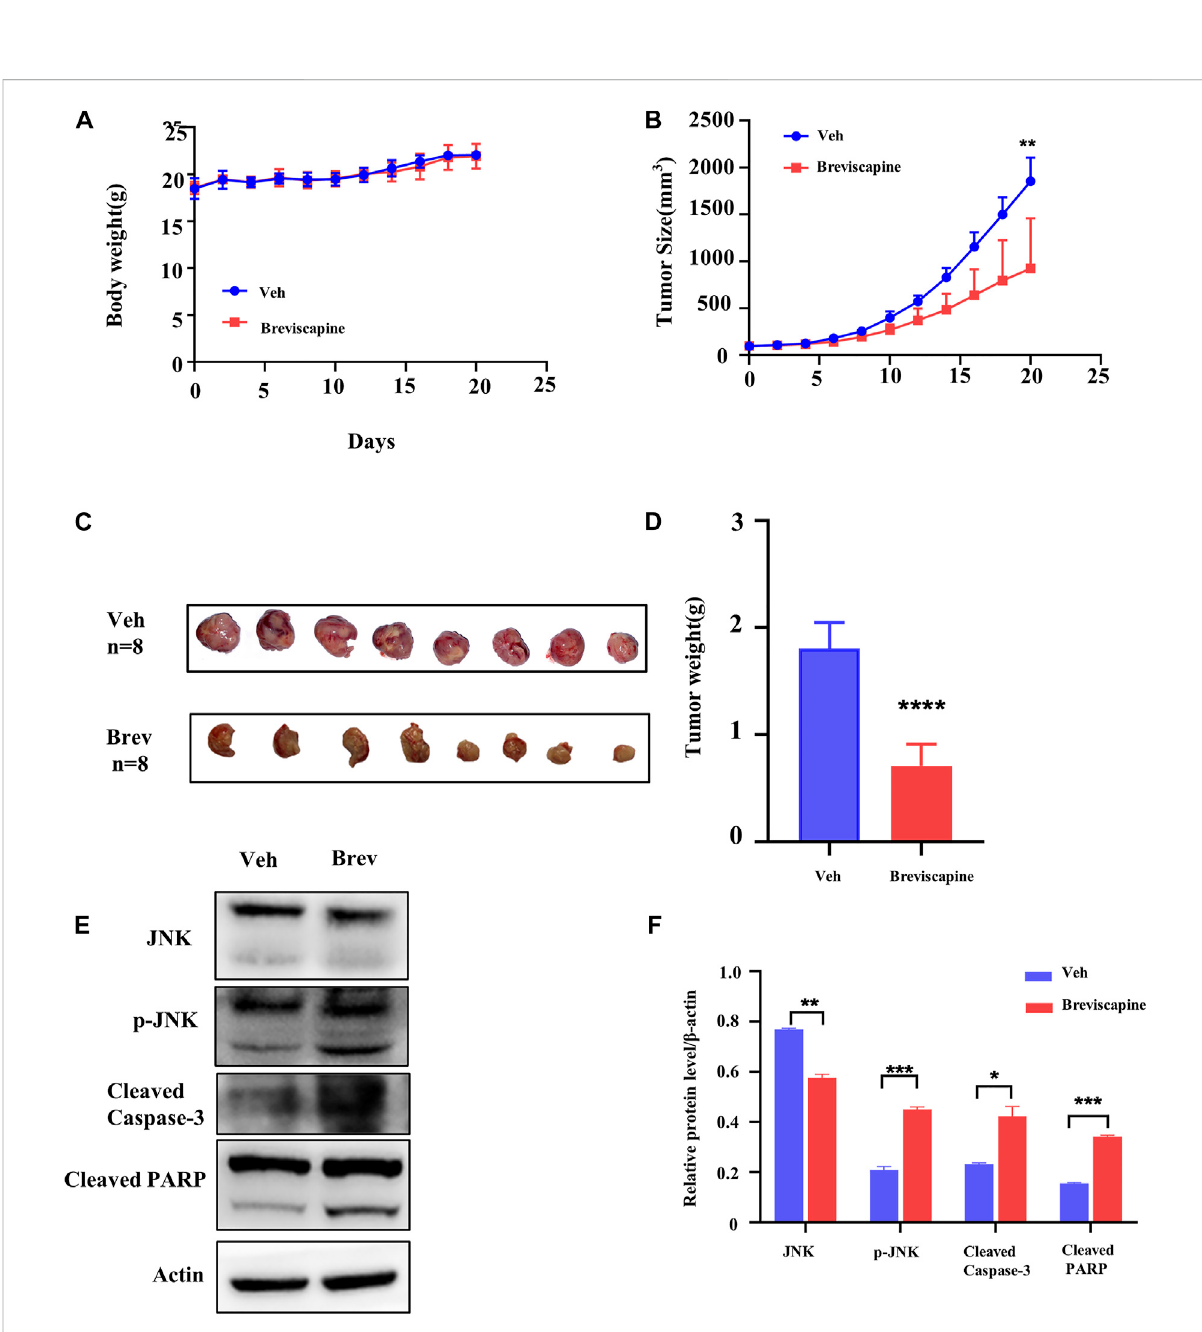
FIGURE 6 Scutellarinsuppressesxenograftgrowth invivo model. (A) Theaveragebodyweightinbreviscapine(60 mg/kg/d,po)andvehicle(normalsaline, po) groups. (B) Xenograft size from nude mice in breviscapine and vehicle groups. (C) Xenograft excised from nude mice in each group. (D) The averageweightofeachxenograft. (E) ThelevelsofJNK,p-JNK,cleavedCaspase-3andcleavedPARPinthetumorswithbreviscapinetreatmentwere evaluated by Western blotting. (F) The statistical analysis result of (E) . Veh n = 8, Brev n = 8. The data were shown as the mean ± SD, ** p < 0.01, **** p <